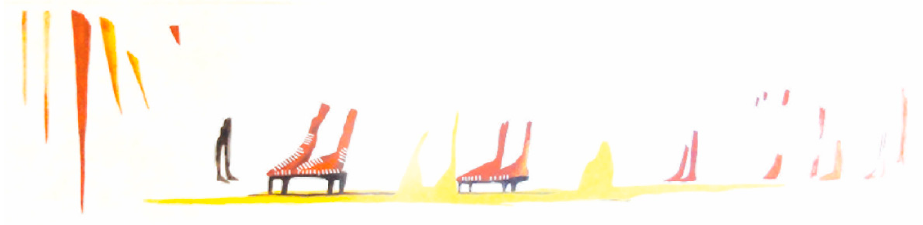
Figure 2. The Notables frieze (created by author).